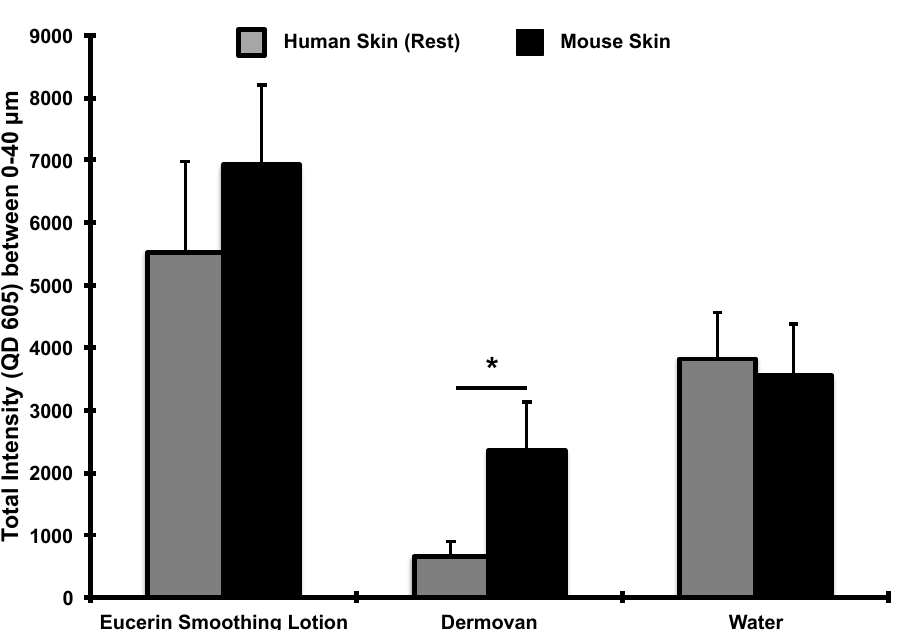
Figure 5. QD penetration trends between ex vivo mouse and rested human skin following a 24 h exposure using the petri dish protocol are comparable. No significant differences in the integrated QD fluorescence intensity were observed in the Eucerin smoothing lotion and water test groups between mouse skin and human skin rested for 24 h post-processing. A ~3-fold higher QD presence was observed in the Dermovan group was detected in mouse skin relative to rested human skin; mean ± SEM ( N = 4, n = 3). * p < 0.05.